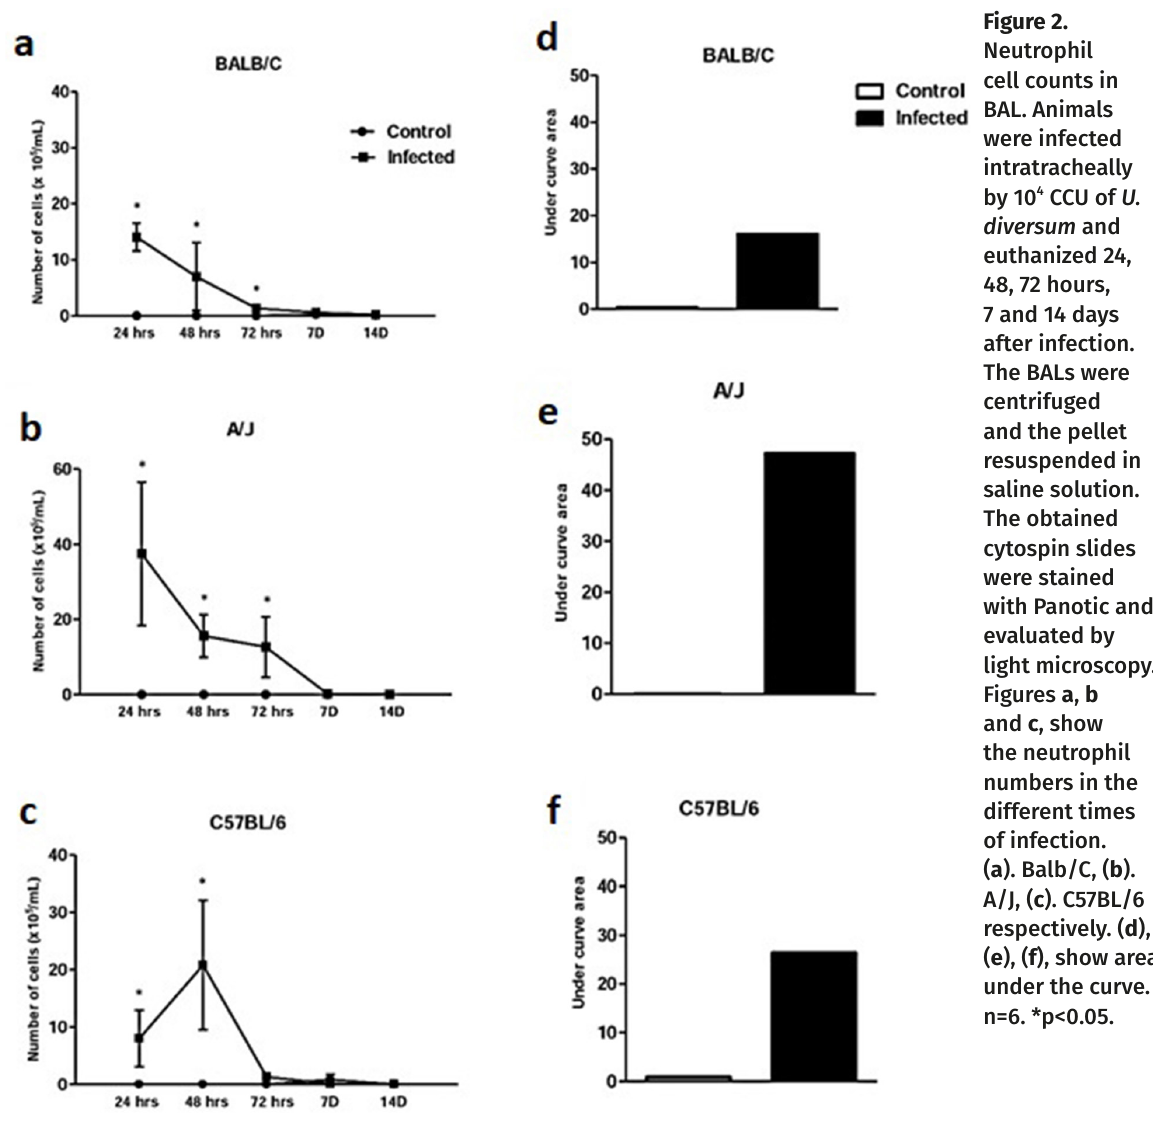
Figure 2. cell counts